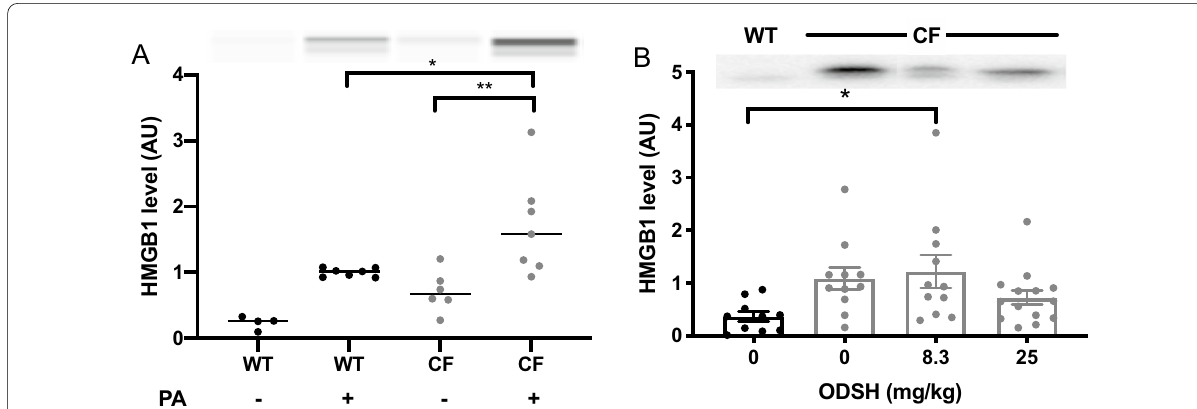
Fig. 5 ODSH decreases airway HMGB1 accumulation in PA infected CF mice. A C57BL/6 mice (WT) and CFTR − / − mice (CF) were randomized and inoculated with normal saline (without PA) or PA (1 10 7 CFUs/mouse) for 18 h. Bronchoalveolar lavage fluid (BALF) was collected from mice was × analyzed for the levels of extracellular HMGB1 by Immunoblot blot analyses. Representative images of immunoreactive bands of HMGB1 in the samples were shown on the top of the bar graphs. B C57BL/6 mice (WT) and CFTR −/− mice (CF) were intratracheally inoculated with Pseudomonas aeruginosa (PA) at T 0 and were randomized to receive via i.p. administration of saline or ODSH at 8.3 or 25 mg/kg ta T 0 and 12 h. BALF = = was collected 18 h after infection (T 18 h) and was analyzed for the levels of airway HMGB1 by Western blot analysis. Levels of HMGB1 were = represented by relative densitometric values and expressed in AU. Each value represents mean SEM of three independent experiments for each ± group. *, P < 0.05; **, P < 0.01 compared to WT groups infected with PA ( A ). *, P < 0.05 compared to CF control groups receiving normal saline. One-way ANOVA was used for multiple group comparison to determine statistical